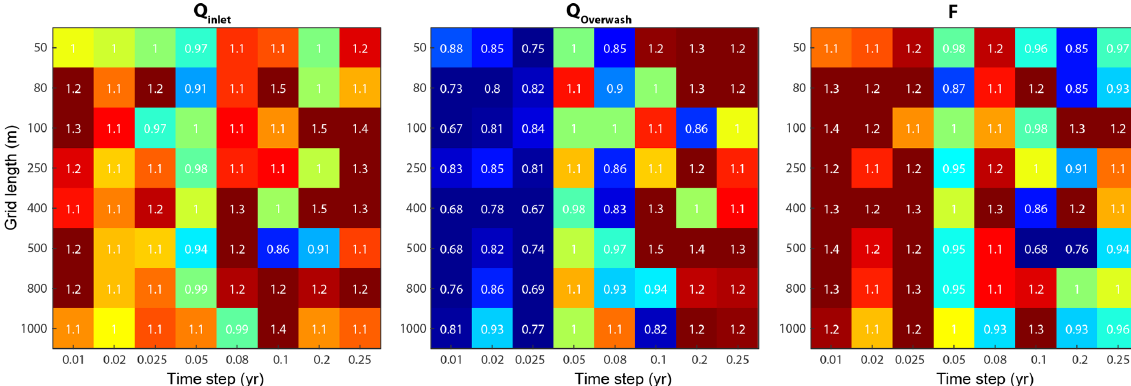
Figure 9. Tidal-induced transgressive sediment flux, storm-overwash-induced transgressive sediment flux, and the ratio F as a function of grid length and time step normalized by their values at a time step of 0.05 years and 100m alongshore grid discretization.